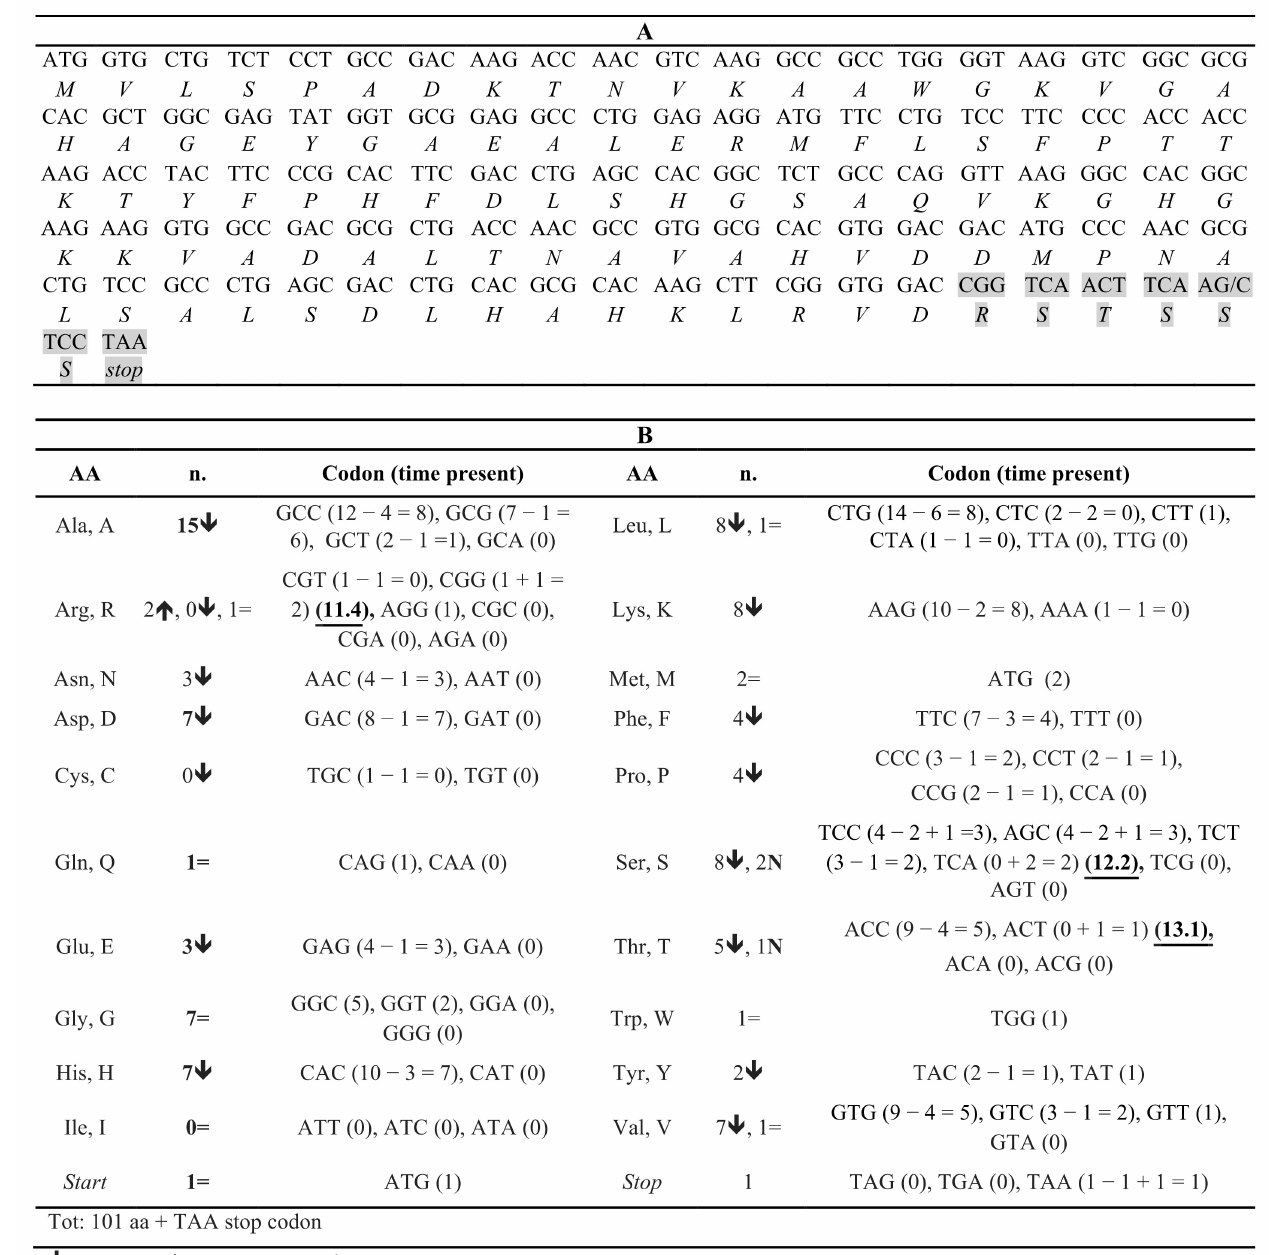
Figure 4. ( A ) Nucleotide triplets coding the Hb Campania ( α 1 cod95 ( − C)) mRNA, from the ATG to the stop codon at position 102; below, the corresponding amino acids present in this α -globin chain variant. The changes in amino acids following the frameshift after cod95 are shown in gray. The symbol / indicates the position of the exon2/3 boundary. ( B ) Types of amino acids present in the Hb Campania α -globin chain, the corresponding coding triplet, and the number of appearances in the Hb Campania mRNA. The numbers underlined and in bold indicate the codon usage